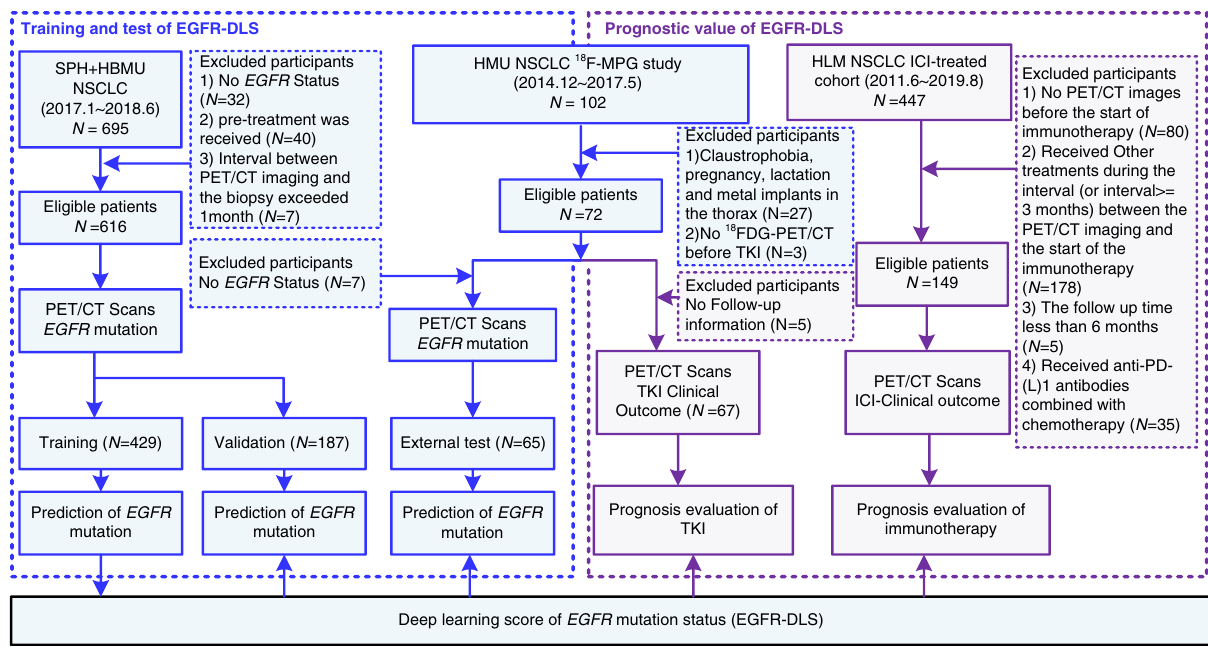
Fig. 1 Study design and inclusion and exclusion diagram. The SPH and HBMU data comprised EGFR mutation status and the corresponding imaging data, and was used to train and validate the deep learning score (EGFR-DLS) generated by the deep learning model. The HMU TKI-treated data comprised EGFR mutation status, and the corresponding imaging data was used for the external test of the EGFR-DLS and also used for the investigation of the prognostic value of the EGFR-DLS for TKI treatment. The HLM ICI-treated data comprised patients included in anti-PD-1 and anti-PD-L1 immunotherapy, and was used for the investigation of the prognostic value of the EGFR-DLS for